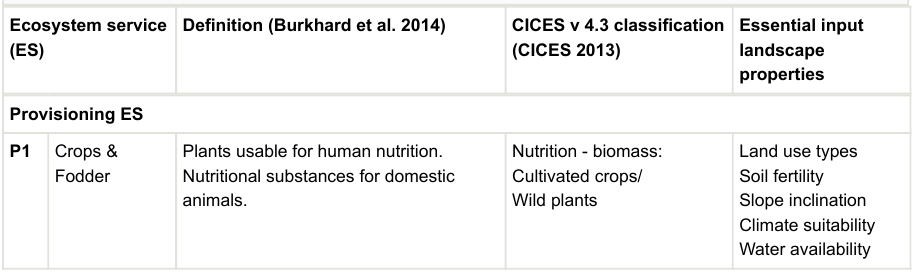
Table 1. List of relevant ecosystem services, their definition and primary data for